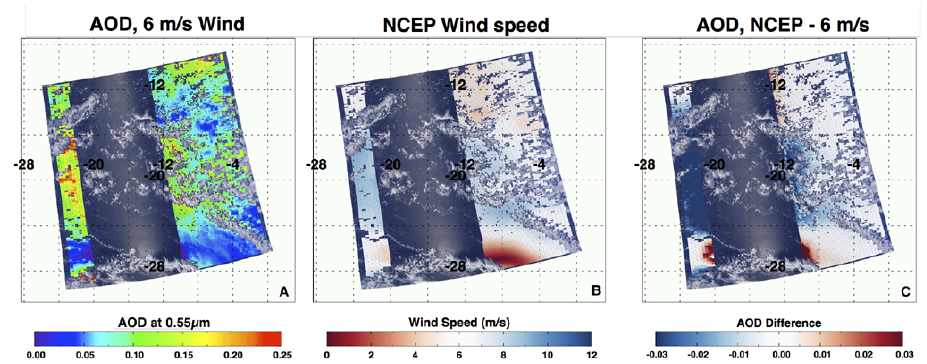
Fig. 12. Granule retrieved over the Atlantic Ocean from MODIS-Aqua taken on 18 January 2010 at 14:40UTC. (a) True-color image (RGB), over plotted with AOD using assumed 6ms − 1 wind speed. (b) Interpolated NCEP 1 ◦ × 1 ◦ wind speed. (c) Change in AOD with use of wind